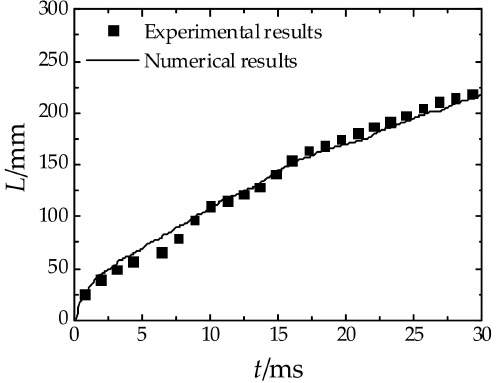
Figure 15. Penetration of underwater gaseous jets (100m, expansion ratio of 1.5625).